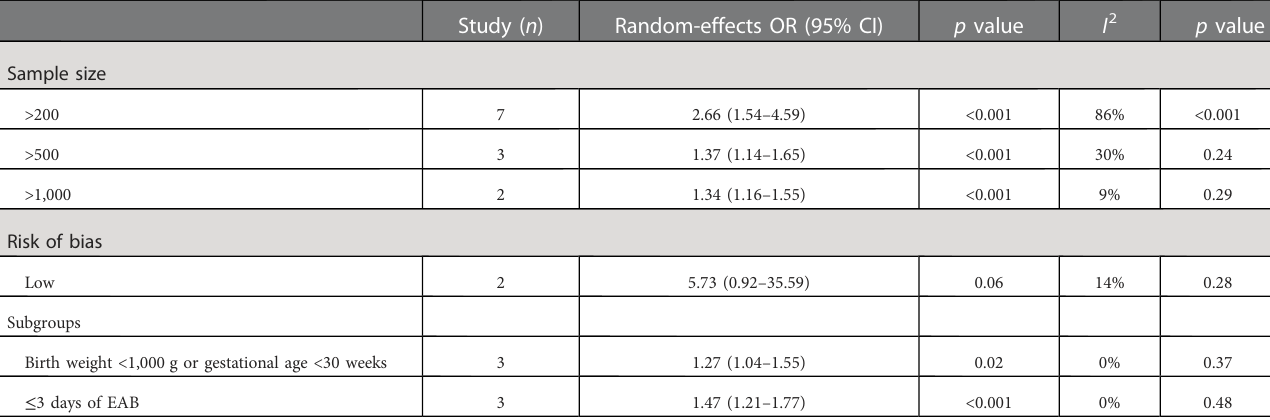
TABLE 5 Sensitivity and subgroup analysis of all included observational cohort studies comparing EAB and